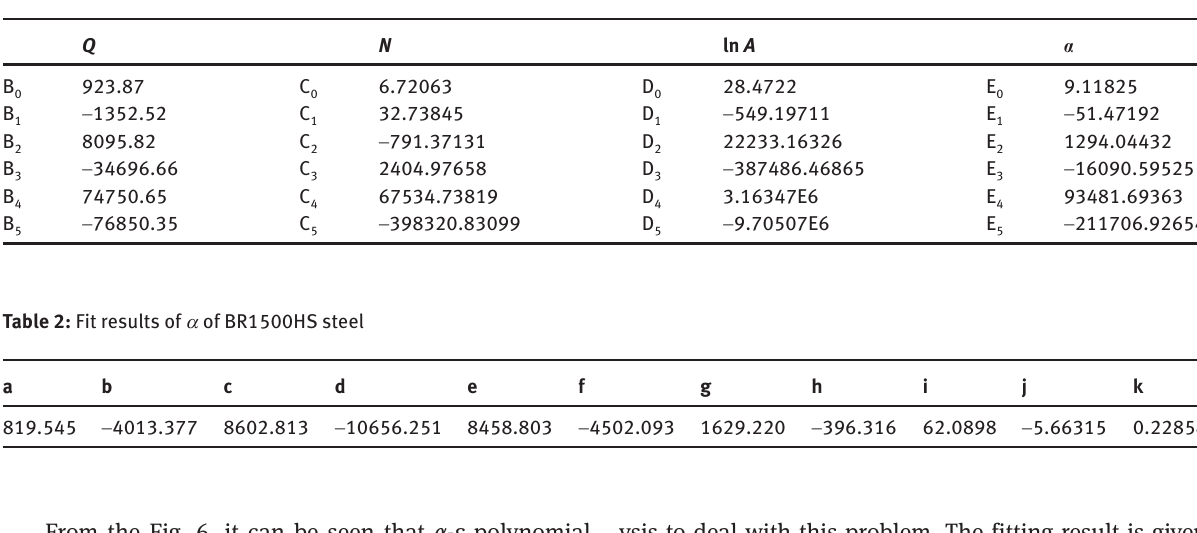
Table 1: Polynomial fit results of Q , n , ln A , and a of BR1500HS steel